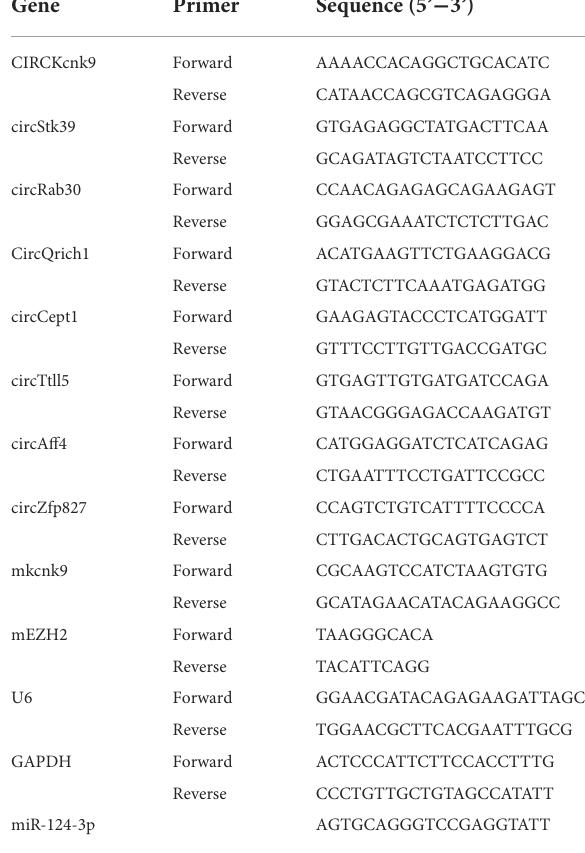
TABLE 1 Primer used qRT-PCR